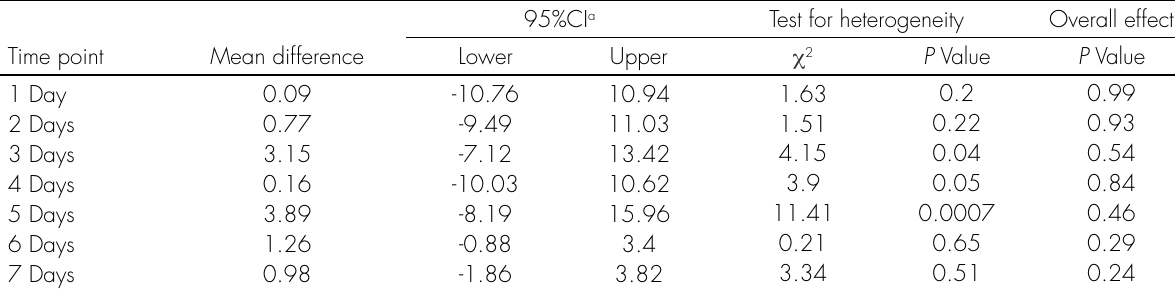
Table VIII. Meta-analysis Data Summary: Structured phone call follow-up vs Structured text follow-up.